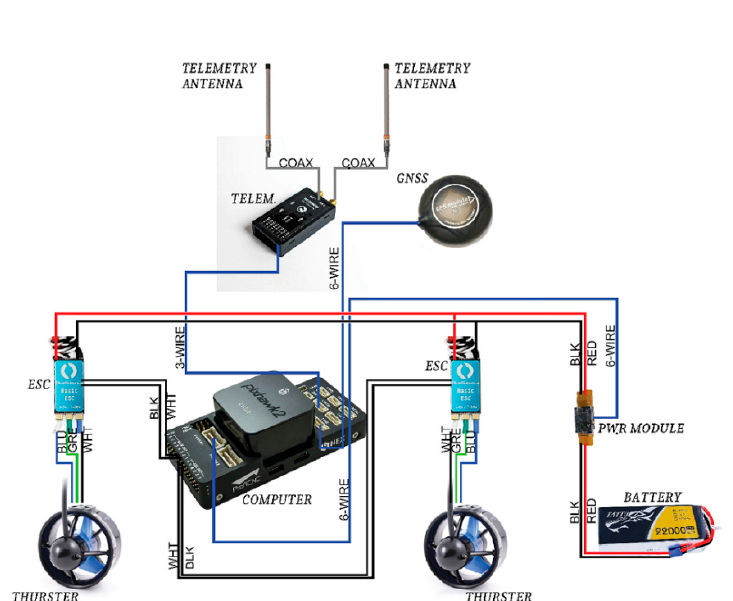
Figure 6. A schematic diagram of the main components subjected to the USV modernisation.